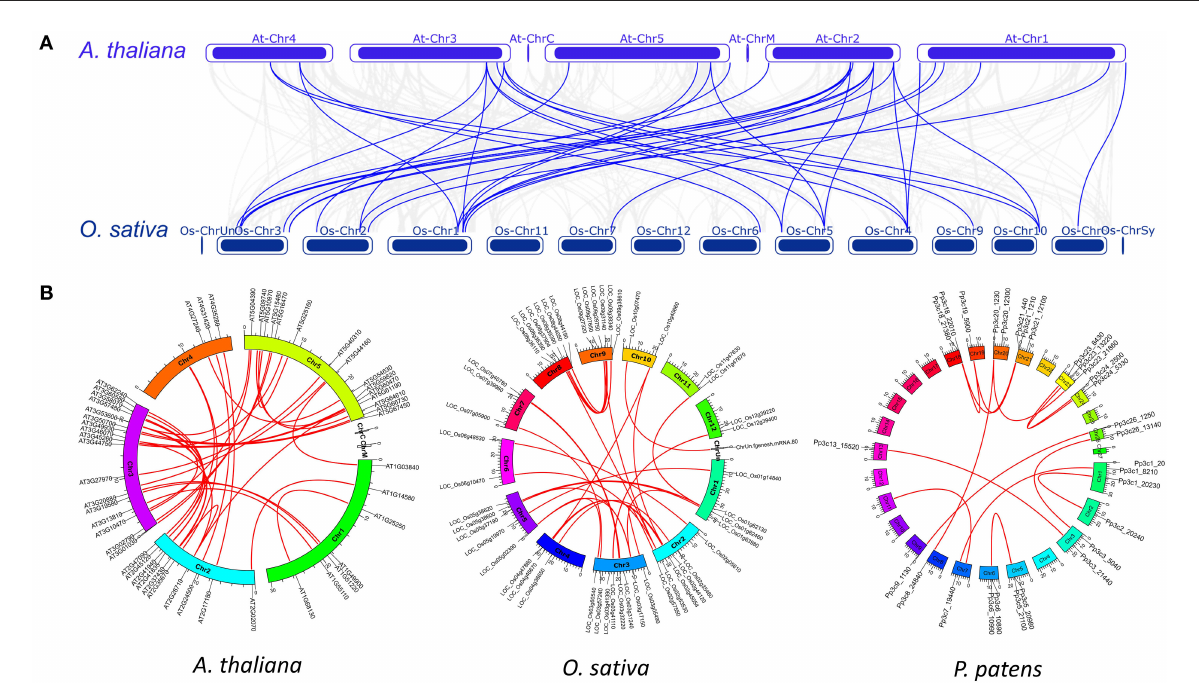
FIGURE1 Interspecific and intraspecific syntenic relationships of C2H2-ZFPs in the representatives. (A) Syntenic relationships of C2H2-ZFPs between A. thaliana and O. sativa . Gray lines in the background indicate the genome-wide syntenic blocks while red lines highlight the syntenic gene pairs of C2H2-ZFPs. (B) Syntenic relationships of C2H2-ZFPs in A. thaliana , O. sativa and P. patens . Gray lines in the background indicate the genome-wide syntenic blocks while red lines highlight the syntenic gene pairs of C2H2-ZFPs